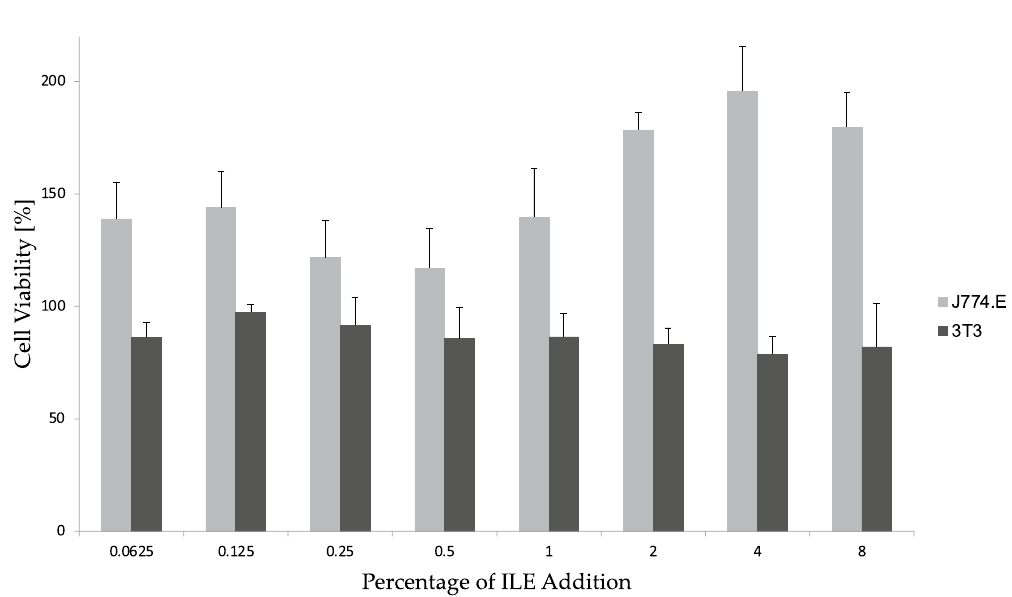
Figure 3. The impact of Intralipid on the viability of two cell lines. The values are presented as mean viability compared to the control cells, and vertical bars indicate the standard deviation associated with the result (n =